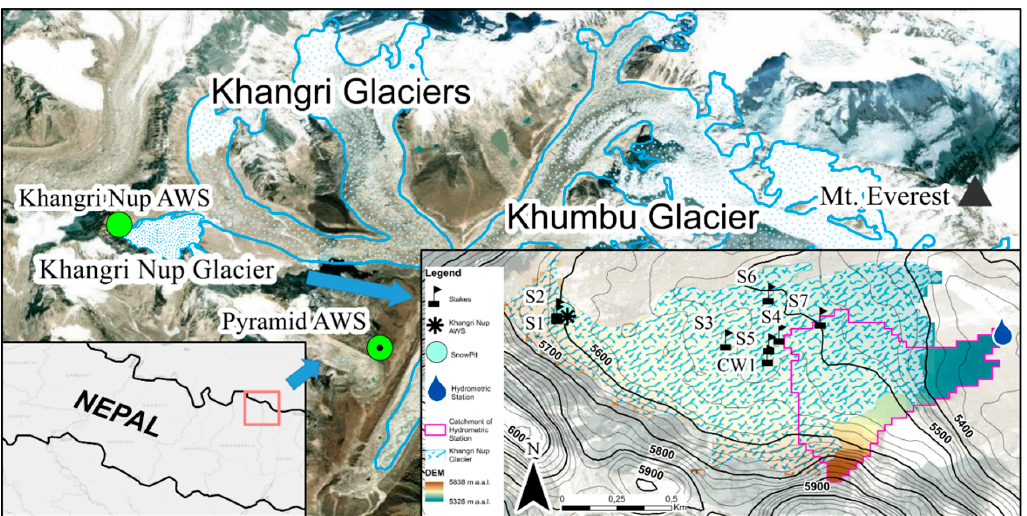
Figure 1. West Khangri Nup glacier, Sagarmatha National Park, Figure 1. Case study area. West Khangri Nup glacier, Sagarmatha National Park, Nepal. The hydro- meteorological stations set up and used for this study are reported. We also report the position of the ice/snow ablation stakes and the results of snow pit survey carried out during the field campaigns (2010–2014, see also Tables 1 and 2). The contributing area at the hydrometric station is also reported.